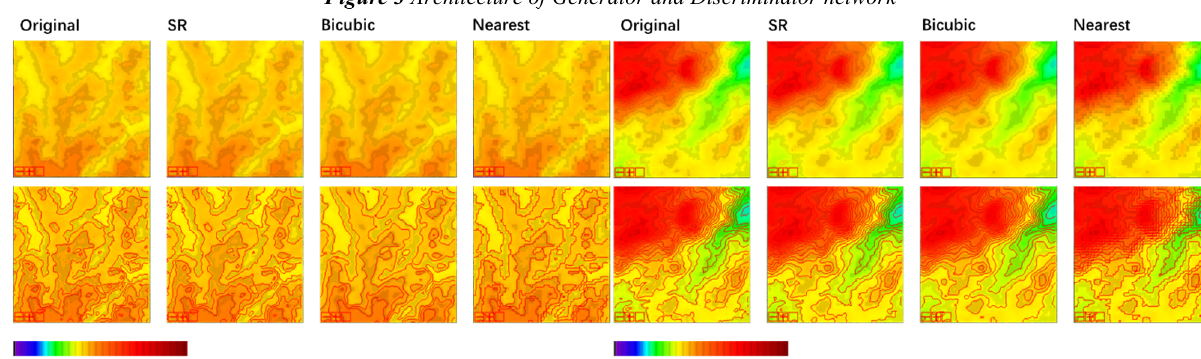
Figure 4 Qualitative results of ESRGAN-based DEM SR